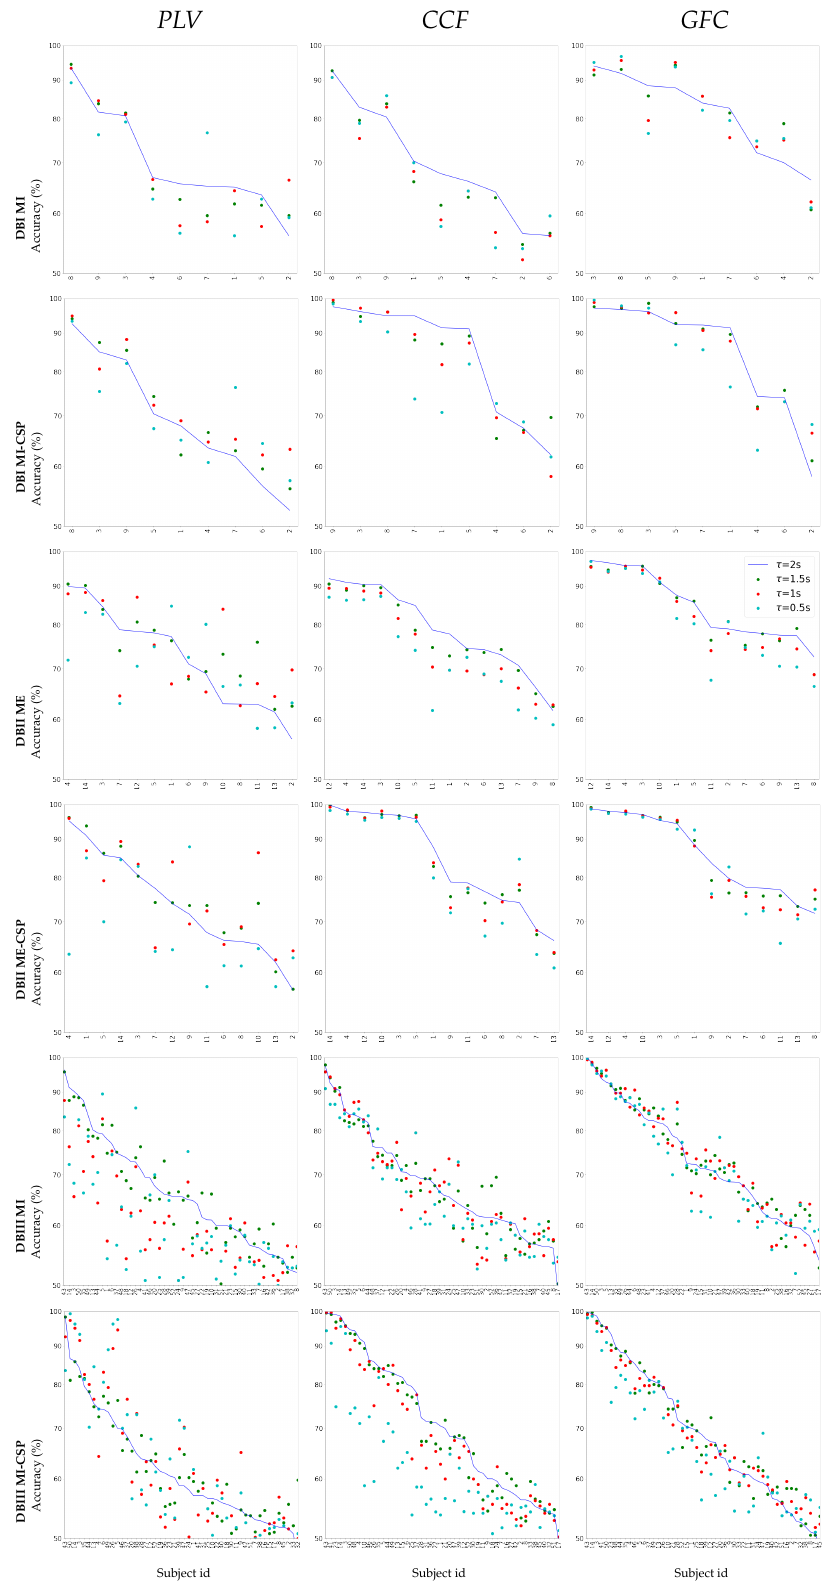
Figure 1. Subject accuracy at each window length τ performed by the evaluated FC measures: PLV, CCF, and GFC. Subjects are displayed on the horizontal axis in decreasing order of each FC accuracy at τ = 2s. Notation CSP stands for the accuracy estimated after the spatial CSP